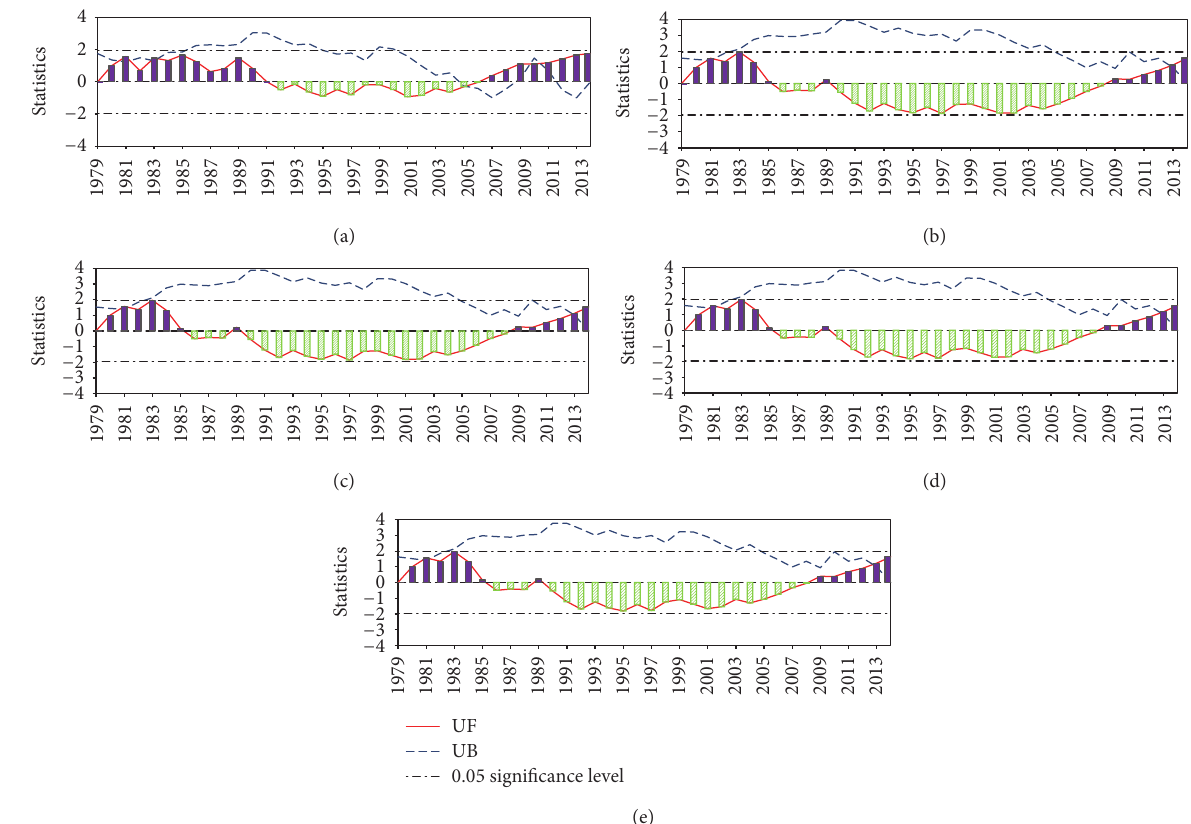
Figure 8: 1979–2014 estimated change in annual runoff based on the sequential Mann-Kendall test at the Yingluoxia (a), the Caotanzhuang (b), the S213 Bridge (c), the G312 Bridge (d), and the Tielu Bridge (e).